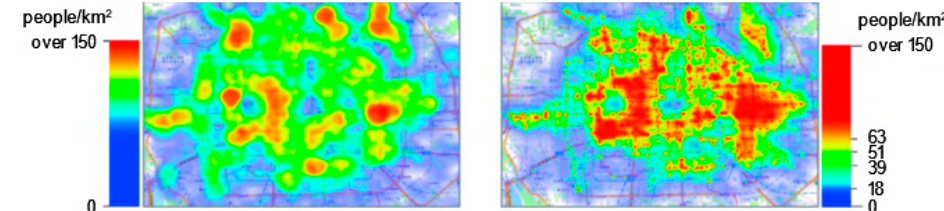
Figure 16. Heatmap views of spatial tweet distribution during a hurricane disaster [50].